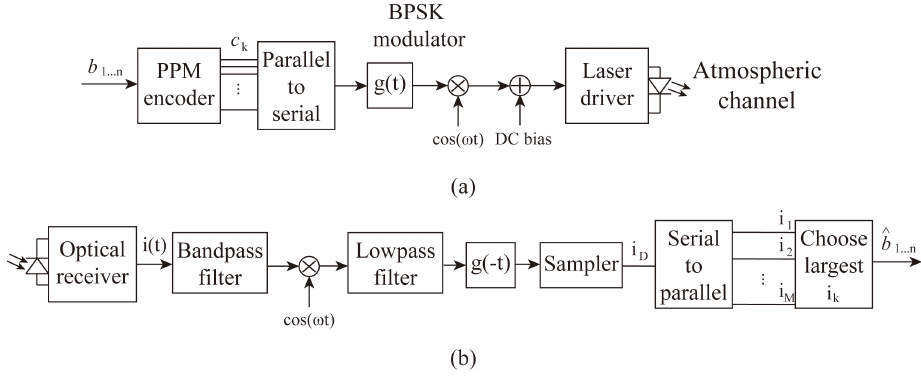
Figure 4. Block diagram of the hybrid PPM–BPSK–SIM system; ( a ) transmitter, ( b )